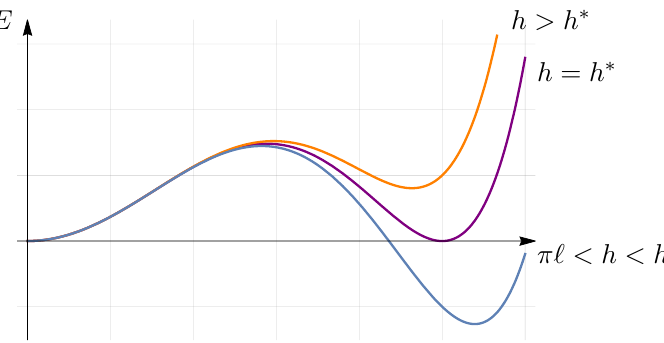
Figure 16 . The potential energy as a function of the configuration space of the web for some values of h , for L > ‘